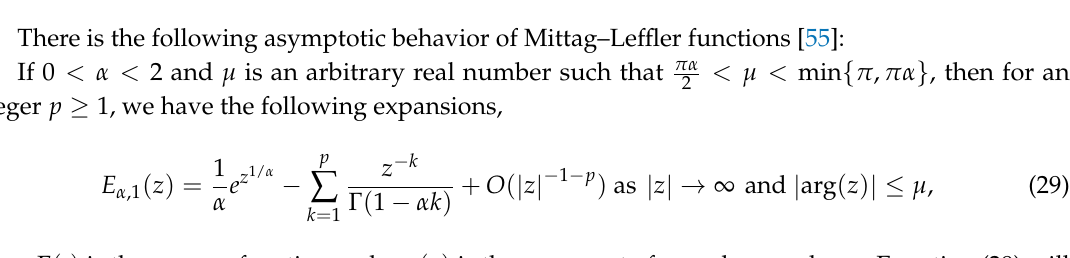
λ π= . Figure 3. Decay rates comparison between Gaussian and anomalous diffusion for λ = π 2